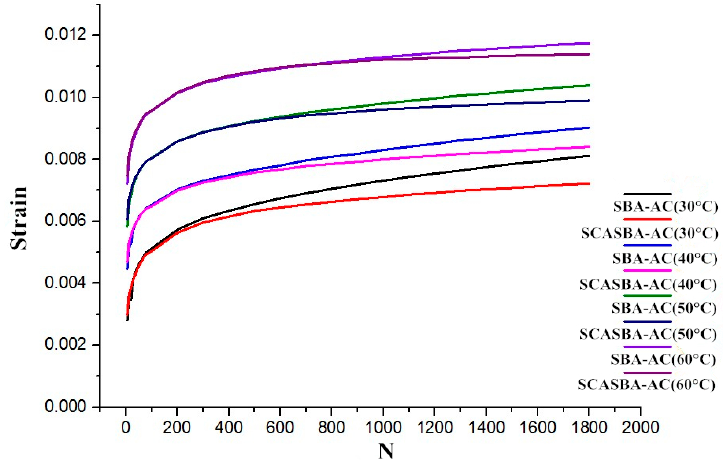
Figure 20. Dynamic creep strain curves of SBA-AC and SCASBA-AC at different temperatures.